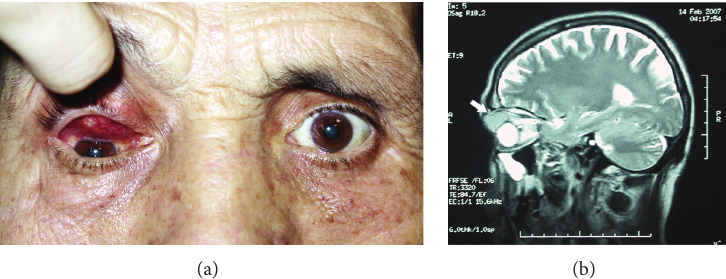
Figure 1: (a) Clinical appearance of the conjunctival mass lesion. Note that the globe is significantly displaced inferiorly. (b) Magnetic resonance imaging of the conjunctival mass lesion (arrow).